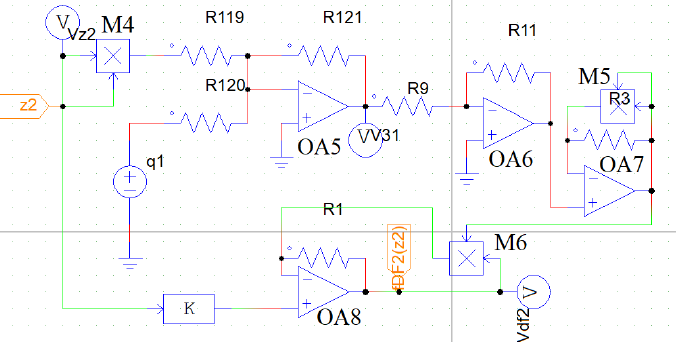
Figure 12. The equivalent circuit diagram of the force due to the dry-friction f DF2 ( z 2 ) . The resistance values are: R 119 = R 120 = R 121 = R 9 = R 1 1 = R 3 = R 1 = 100 k Ω , k = 0.2413. OA 4 to OA 8 are the four Op-Amps, M 4 , M 5 , and M 6 are the three multipliers, q 1 is the dc voltage source with the value of a 2 K is the gain of a proportional block. (Color Online).